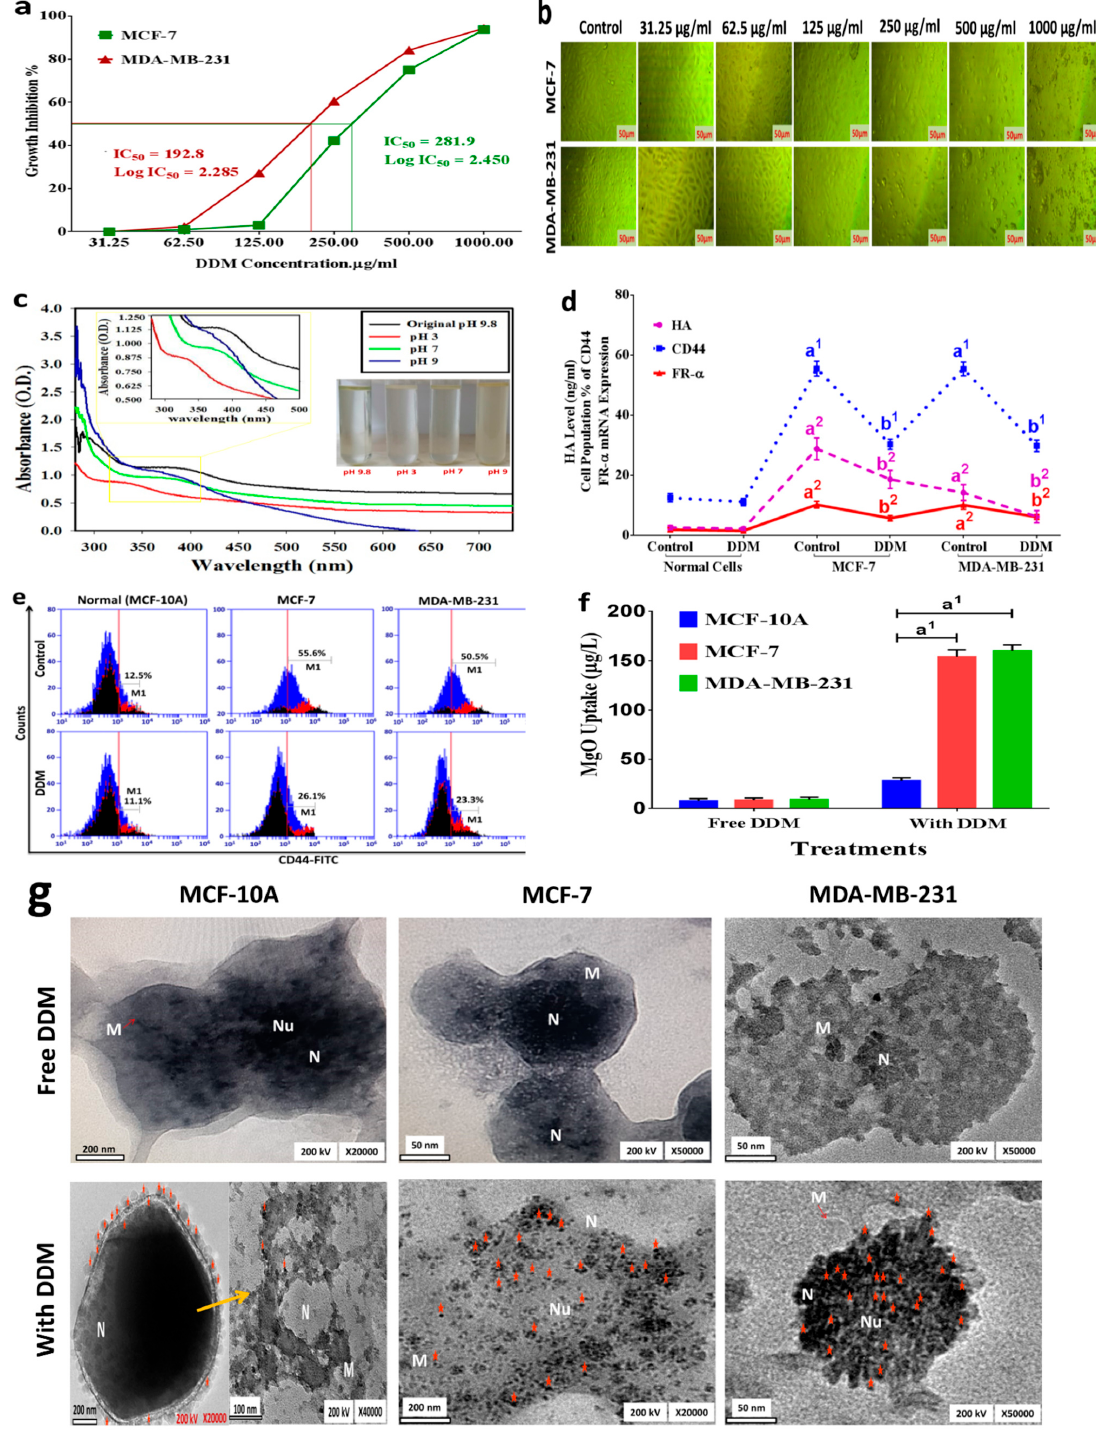
Figure 3. Inhibition of breast cancer (BC) cell proliferation, release, enhanced selectivity, and cellular uptake by DDM. ( a ) MTT assay of BC cells treated with DDM at different concentrations. Values are represented as the mean ± standard error of the mean (SEM) of triplicate samples from two independent experiments. ( b ) Phase-contrast images of MCF-7 and MDA-MB-231 cells were captured by the inverted light microscope. ( c ) The release of DDM at different pH; originally 3,